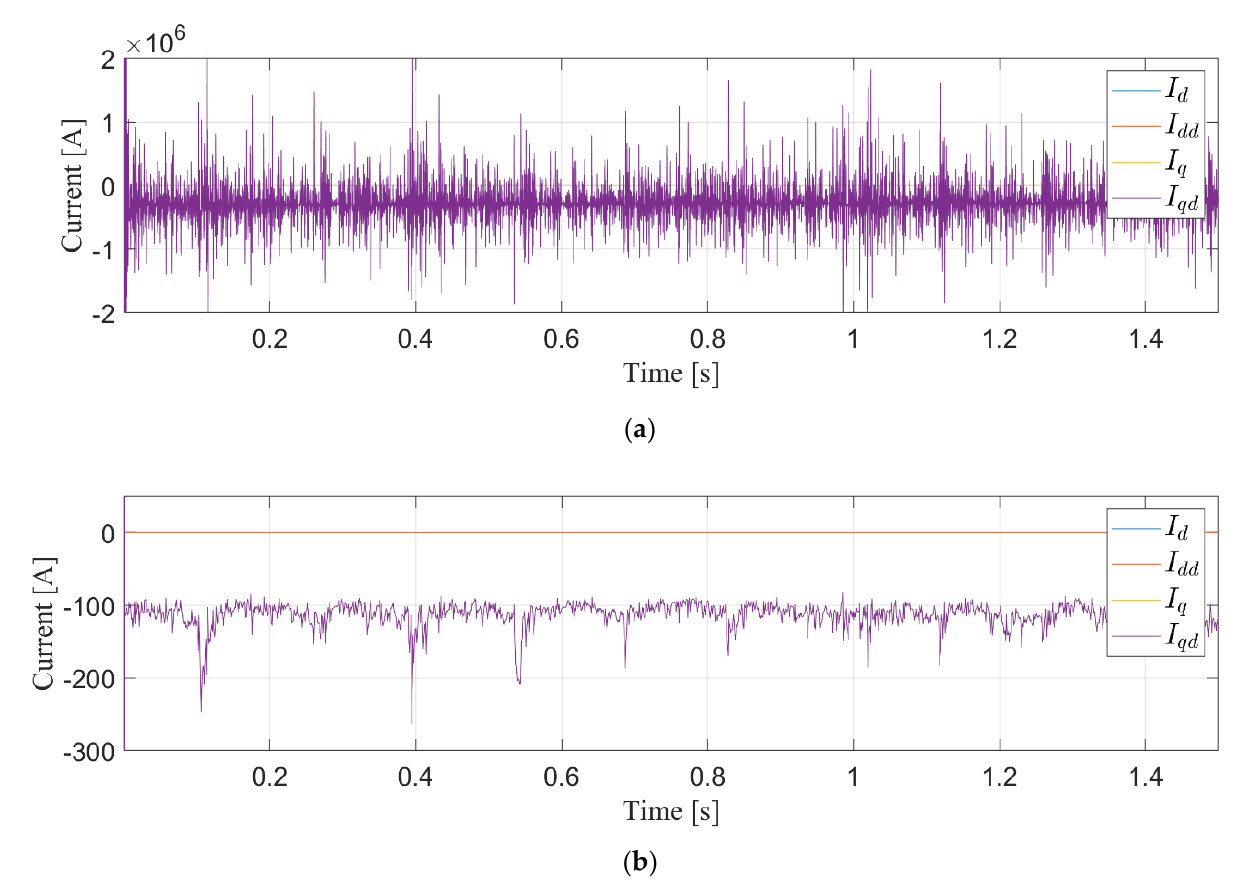
Figure 8. PMSG currents and references for linear controller ( a ) and nonlinear controller ( b ).